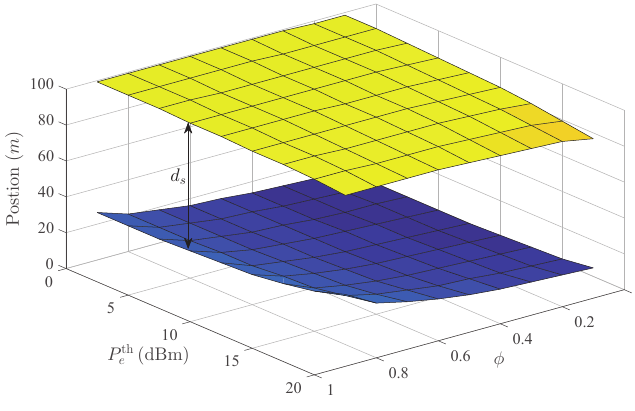
Figure 11. The influence of P th e and φ on d s